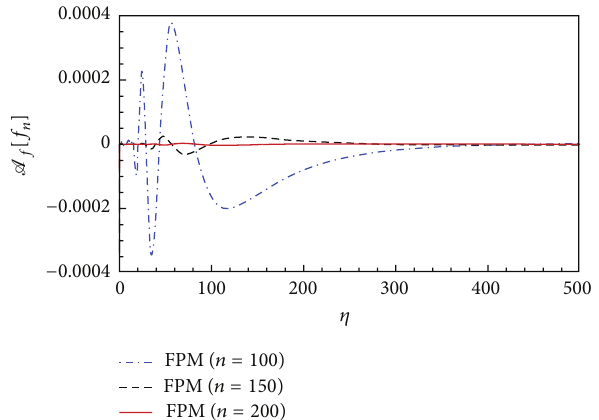
Figure 4: The residual error function A 𝑓 [𝑓 𝑛 ] = 2𝑓 󸀠󸀠󸀠 𝑛 + 𝑓 𝑛 𝑓 󸀠󸀠 𝑛 ( 𝜆 = 1/5